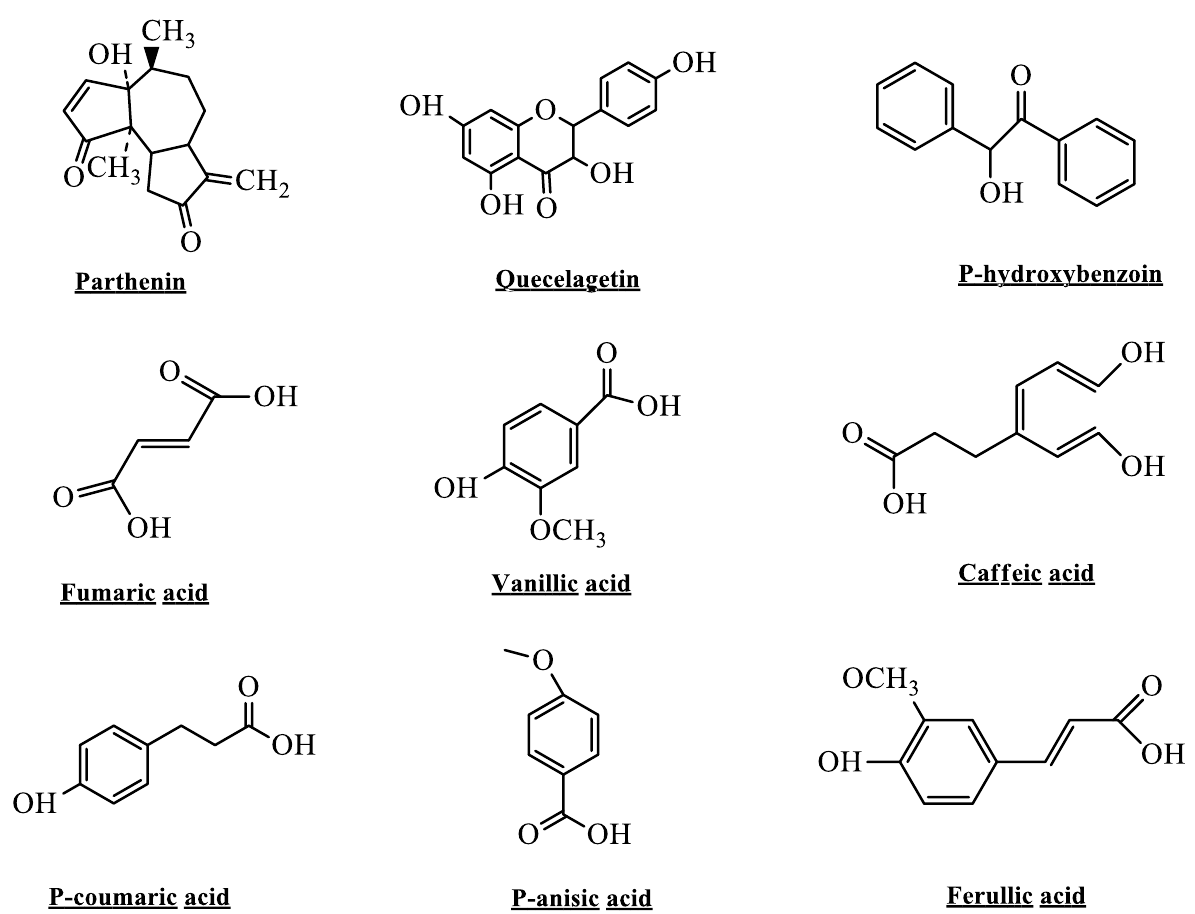
Figure 2. Different phytochemicals isolated from P. hysterophorus plants with potential application in the treatment of various health issues.